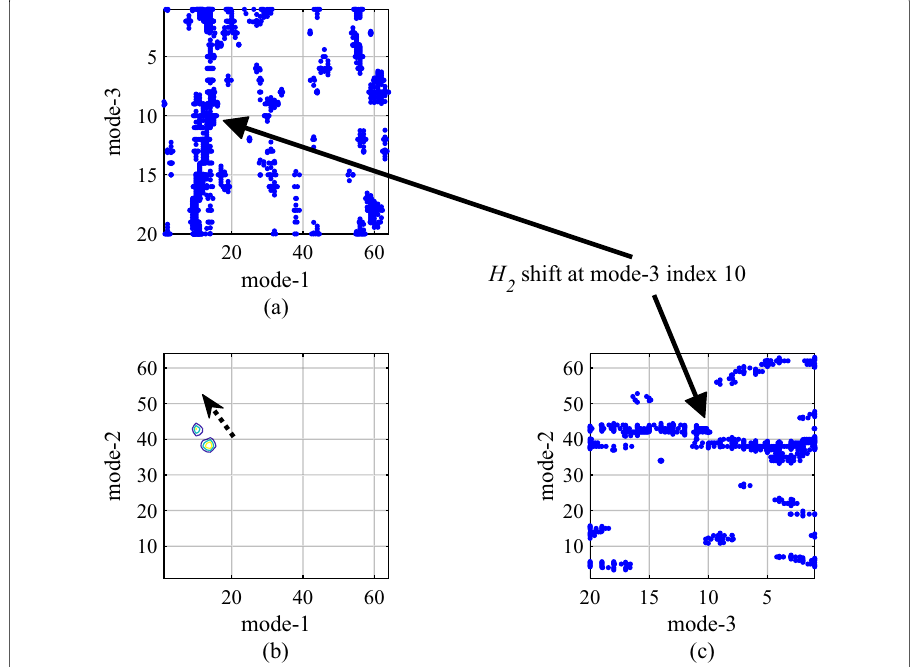
Fig. 9 Phase congruency in data tensor D with apparent motion of H 2 at frame 10 (mode-3 index 10). a , c Scatter plots along mode-3. b 3-level contour plot with dotted-line arrow in direction of motion